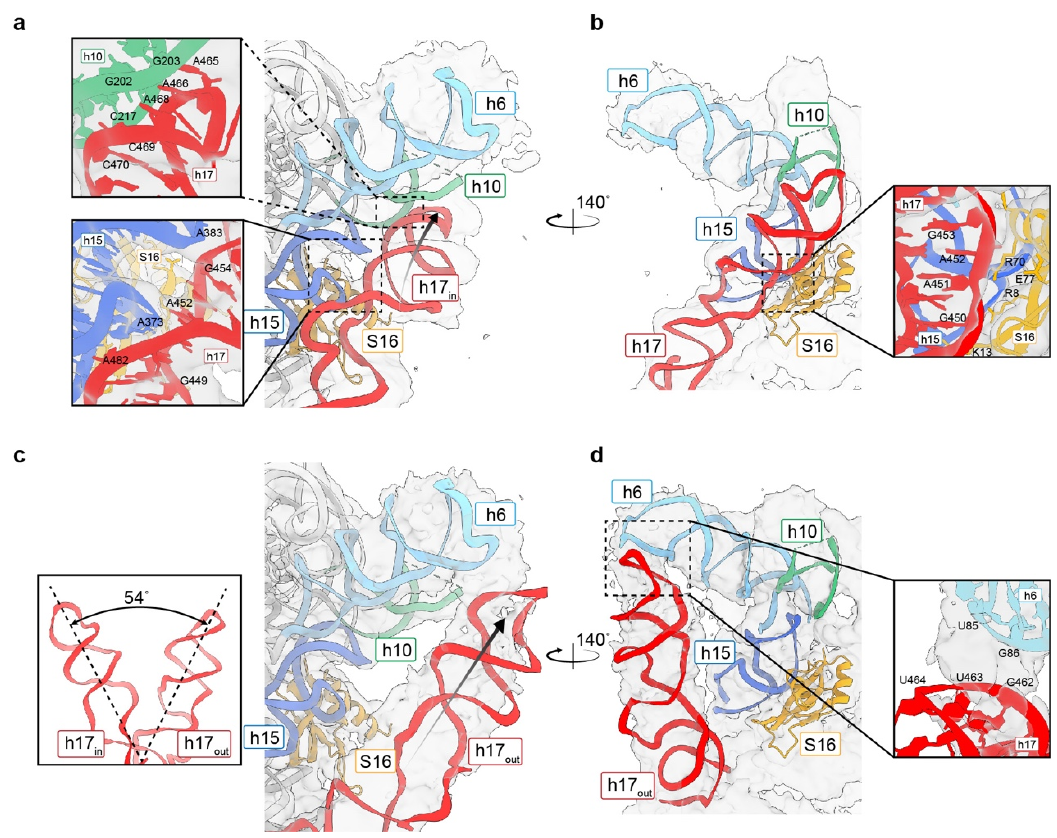
Figure 4. The h17 helix shifted outwards to the tip of h6. ( a ) Interactions between h17 (red), h10 (green), and h15 (blue) in the reconstruction of h17 in . The direction of h17 is labeled with a black arrow. ( b ) Interactions between h17 and S16 proteins in the reconstruction of h17 in . ( c ) Shifting of h17 from h17 in to h17 out . The shifted angle was measured in Chimerax, and the direction of h17 in the h17 out reconstruction is labeled with a black arrow. ( d ) The interactions between the out-shifted h17 and the tip of